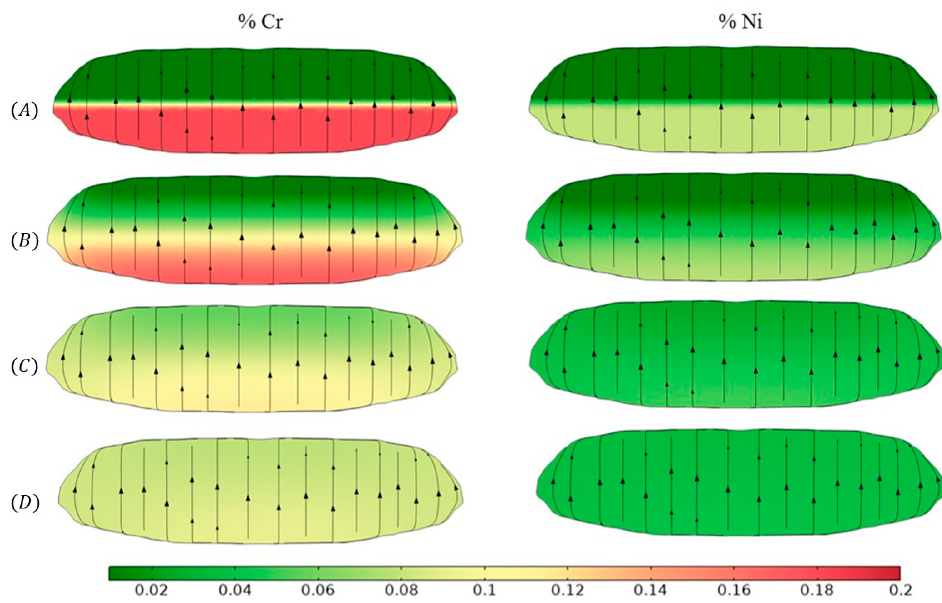
Figure 10. Simulation results of Cr and Ni diffusion in the molten Fe, ( a ) 0.01 s, ( b ) 0.1 s, ( c ) 0.2 s, ( d ) 0.5 s.